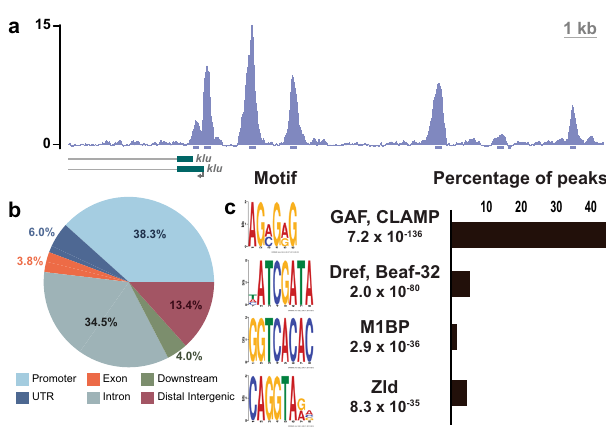
Fig. 3 Zld binds to thousands of loci in type II neuroblasts. a Representative genome browser tracks at the klu locus of Zld ChIP-seq from brat 11/Df(2L)Excel8040 brains. 200 bp regions surrounding the peak summits are shown below the track. b Pie chart of the genomic distribution of Zld-binding sites in type II neuroblasts. Promoters are de fi ned as − 500 to + 150 bp from the transcription start site. c List of enriched motifs for Zld-bound regions in type II neuroblasts identi fi ed by MEME-suite ( left ). The signi fi cance value is based on the log likelihood ratio, width, sites, background, and size of the input sequence. Histogram of the fraction of the 12,208 peaks identi fi ed for Zld ChIP-seq containing the GAF, CLAMP (ACMGRG), Dref, Beaf-32 (HATCGATA), M1BP (GGTCACA), or Zld (CAGGTARV) motif ( right)